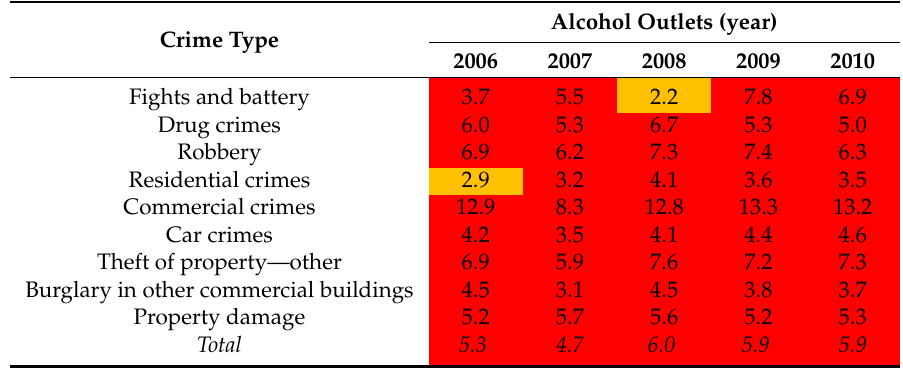
Table 7. LQC values of crime types around alcohol outlets in the distance zone 0–50 m from 2006–2010.